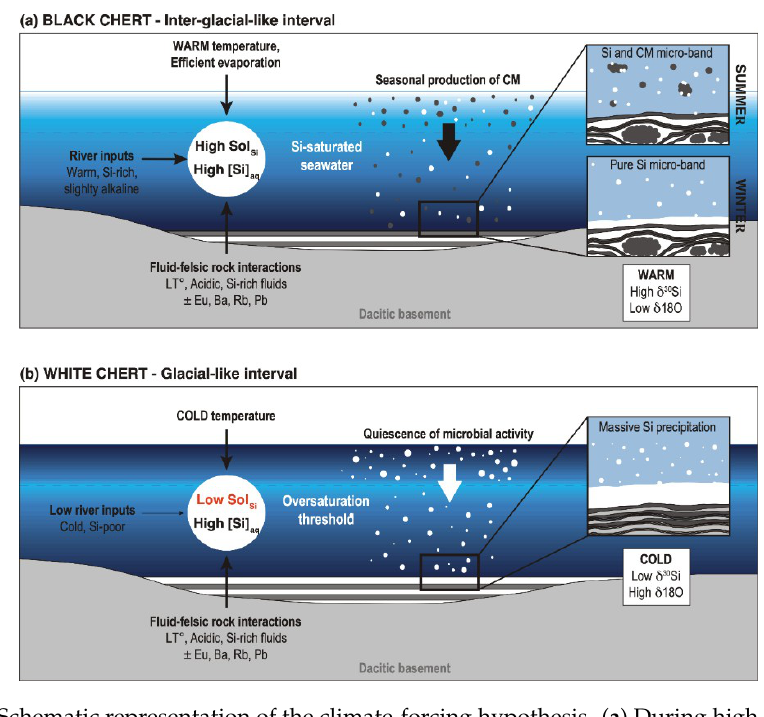
Figure 16. Schematic representation of the climate-forcing hypothesis. ( a ) During high temperature intervals, warm evaporative conditions, silica inputs from the seafloor and possibly slightly alkaline, Si-rich riverine inputs concur to maintain the shallow basin close to silica saturation. Black chert layers are formed by continuous background silica precipitation and seasonal carbonaceous matter deposition during summer periods. ( b ) During low temperature intervals, the temperature and pH drop, which dramatically lowers silica solubility, at least in the shallowest parts of the water column. The basin passes the oversaturation threshold and silica is massively precipitated to form the white chert layers. Microbial communities are in a quiescent state, thus organic matter is absent from the sedimentary record. Isotopic characteristics of the black and white cherts are from Geilert et al. [12].